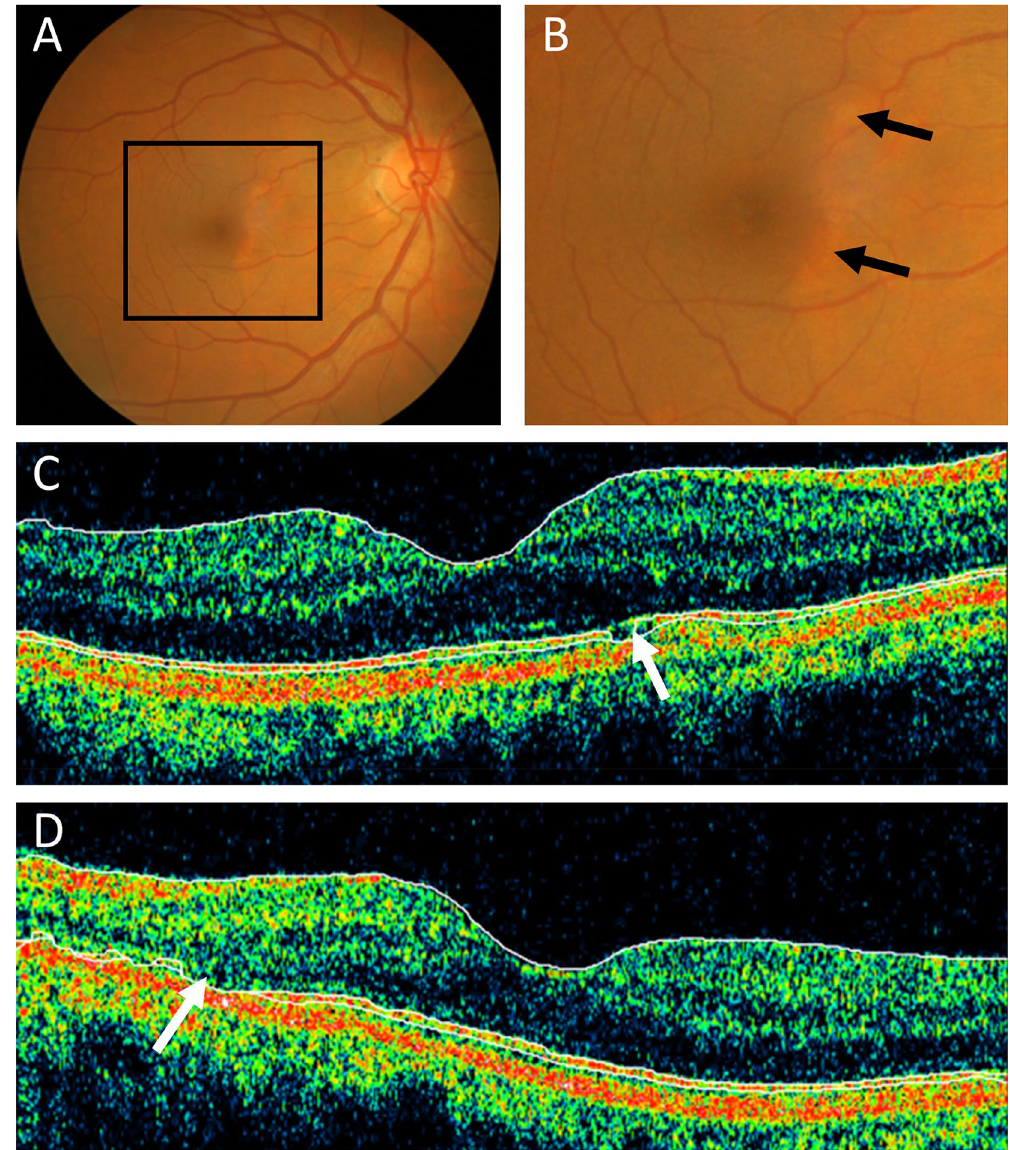
Figure 3. Drusen in a 60 year old man with FSGS. ( A ) Colour fundus photograph of the right eye; ( B ) Magnified view demonstrating focal pallor (arrow) in the nasal area adjacent to the fovea; ( C ) Optical Coherence Tomography (OCT) of the right eye demonstrating defects in the photoreceptor layer consistent with atrophy; and ( D ) similar defect in left